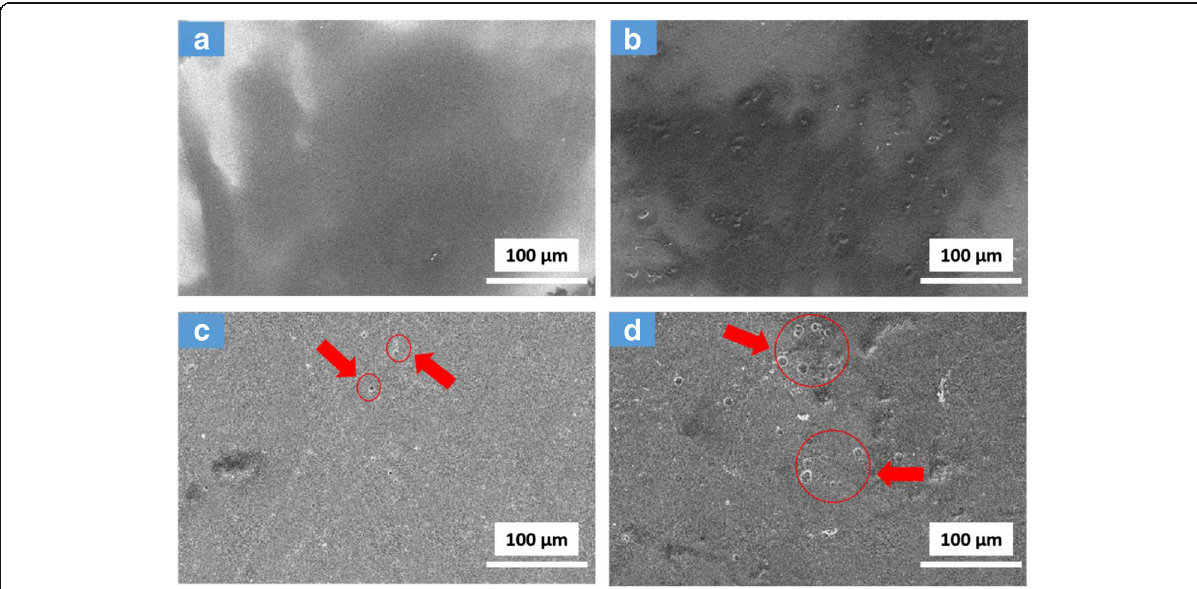
Fig. 11 SEM images of the morphology of PVC ( a , c ) and TNTs/GO-PVC ( b , d ) films before and after 72 h of UV irradiation. More and large cavities were formed on the surface of TNTs/GO-PVC film after UV irradiation, which indicates that the TNTs/GO could promote the photocatalytic degradation of PVC under UV